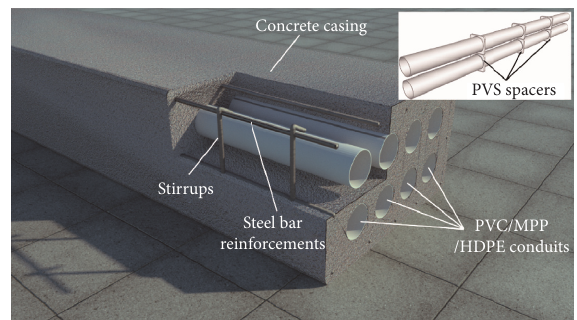
Figure 1: Sketch of concrete-encased underground electrical duct